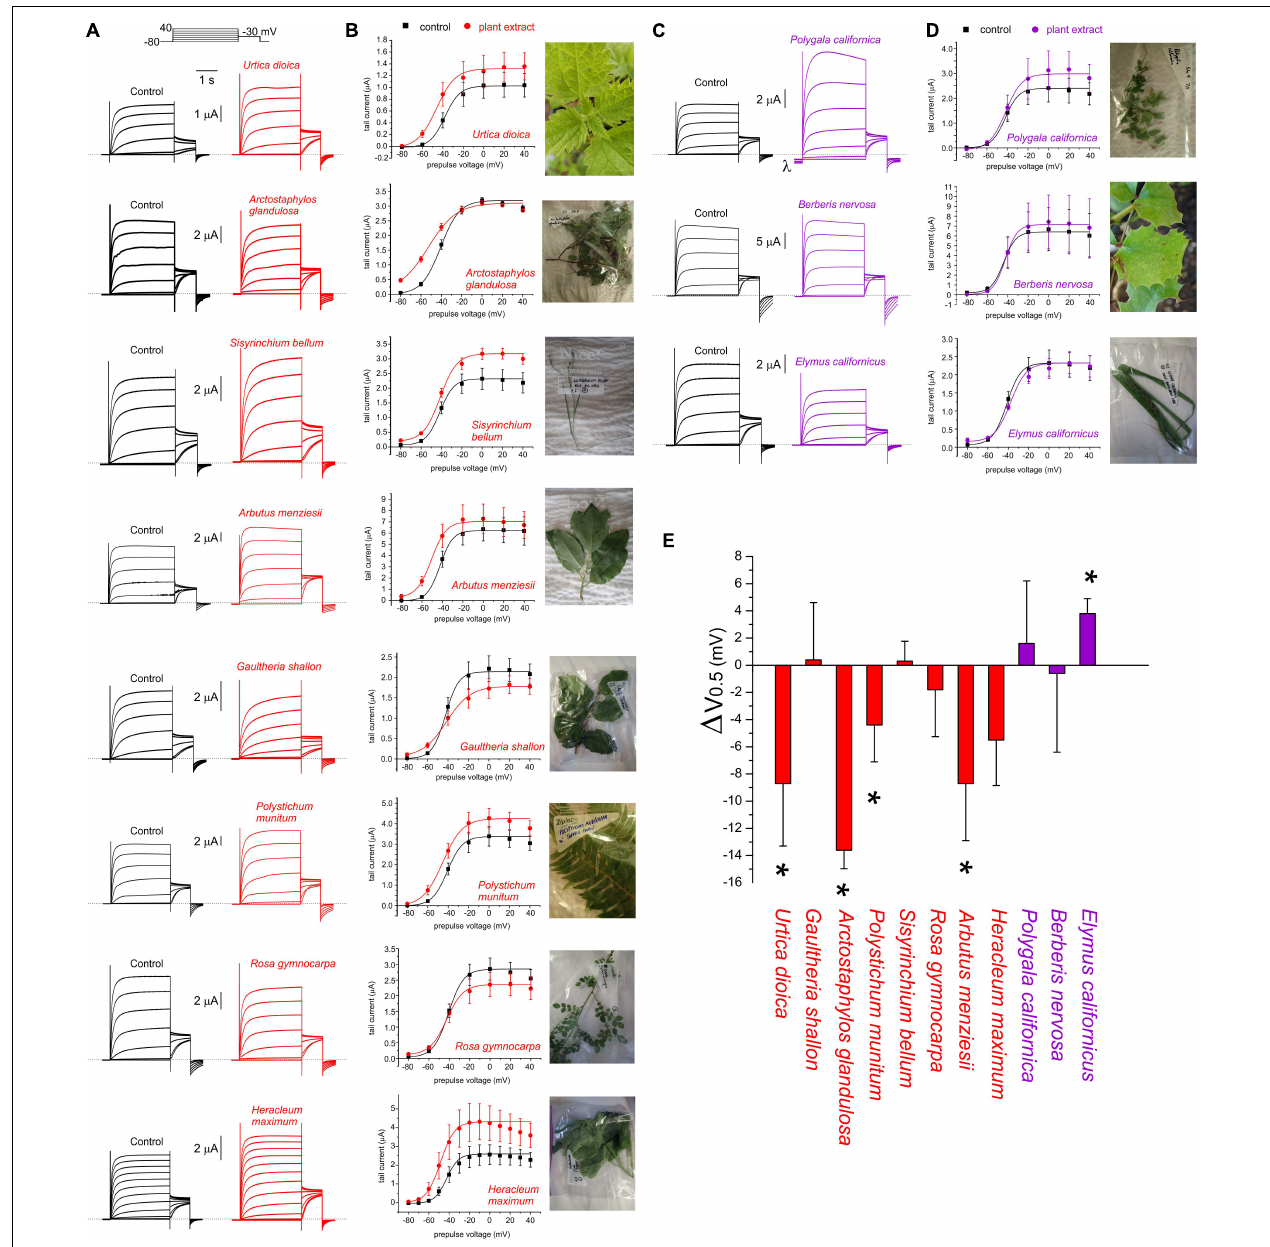
FIGURE 3 | Effects of Muir Woods plants on KCNQ2/3 channel voltage dependence. All error bars indicate SEM. n = number of oocytes. (A) Exemplar TEVC current traces for KCNQ2/3-expressing Xenopus oocytes in the absence (Control) or presence of 1:50 (in bath solution) plant extracts found to activate KCNQ2/3 at hyperpolarized potentials ( n = 4–11). Upper inset , the voltage protocol used here and throughout the study (used with either 10 or 20 mV prepulse increments) unless otherwise indicated. (B) Mean tail current versus prepulse voltage, for traces recorded as in panel (A) , for plant extracts found to activate KCNQ2/3 at hyperpolarized potentials ( n = 5–11). (C) Exemplar TEVC current traces for KCNQ2/3-expressing Xenopus oocytes in the absence (Control) or presence of 1:50 (in bath solution) plant extracts found to not affect or to inhibit KCNQ2/3 currents at hyperpolarized potentials ( n = 3–4). Dashed line here and throughout indicates the zero-current level. λ indicates leak induced by P. californica . (D) Mean tail current versus prepulse voltage, for traces recorded as in panel (A) , for plant extracts KCNQ2/3 ( n = 3–4). (E) Mean shift in midpoint voltage dependence of KCNQ2/3 activation ( (cid:49) V 0 . 5 ) calculated from plots in panels (B) and (D) . * P < 0.05; others, P > 0.05 ( n =